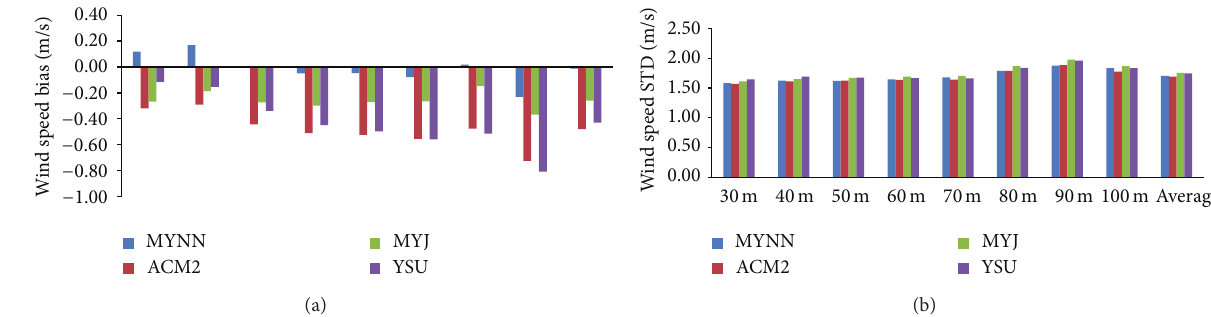
Figure 6: Monthly (March 2005) bias and standard deviation for wind speed at 8 vertical levels (30–100 m) and their average for the four PBL runs (YSU, MYJ, ACM2, and MYNN).